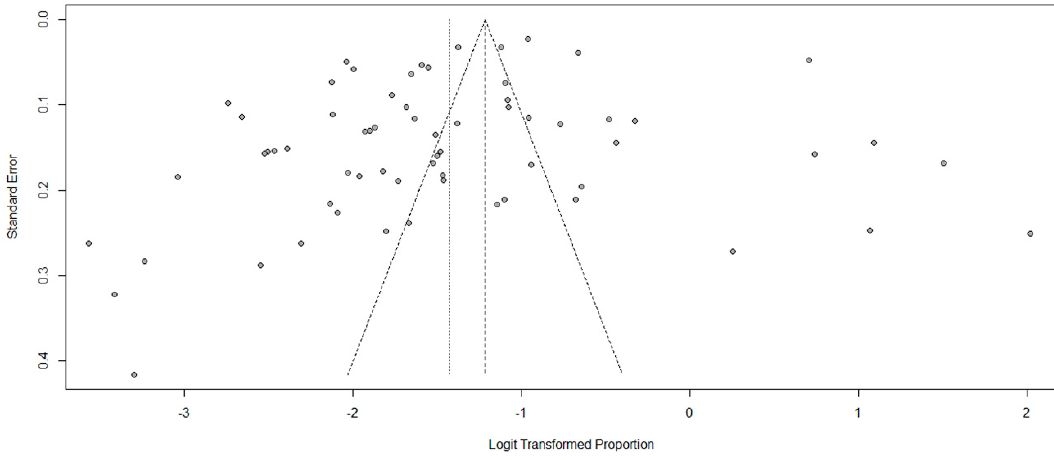
Figure 3. Funnel plots estimating small sample bias.